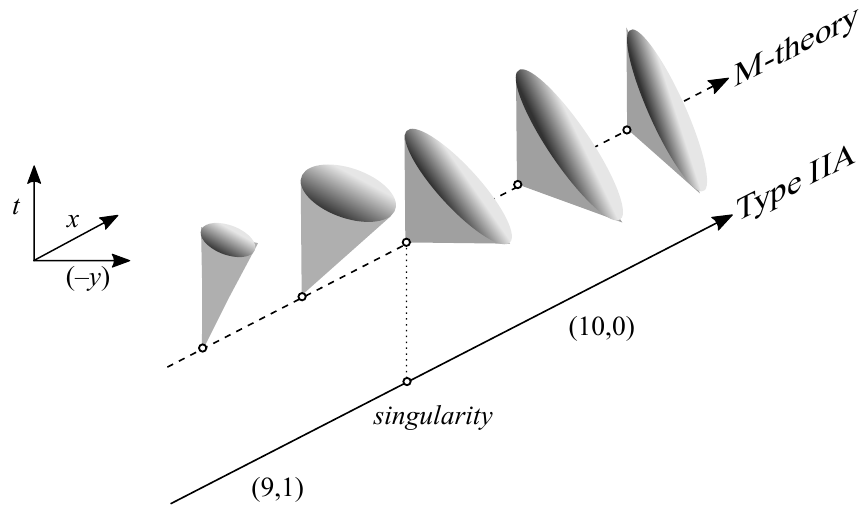
Figure 2 . The forward light cone in the y { t plane of the M-theory pp-wave background d s 2 d s 2 + 2d t d y + H d y 2 as a function of some transverse coordinate x . When @ y becomes null, the 9 signature of the compact circle changes from spacelike to timelike, resulting in a naked singularity and a change of spacetime signature in the type IIA